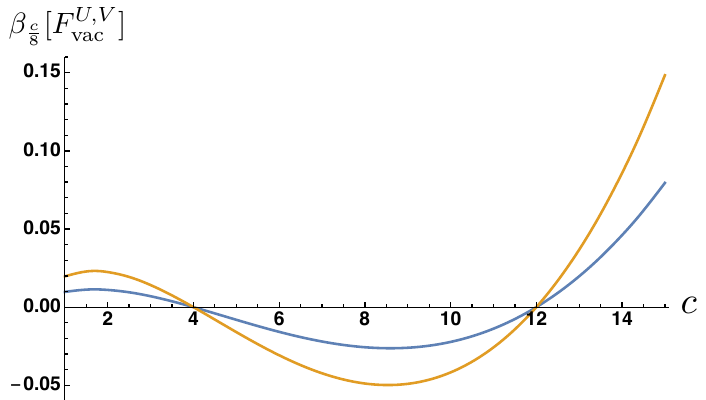
on the vacuum modular bootstrap vectors F U;V 8